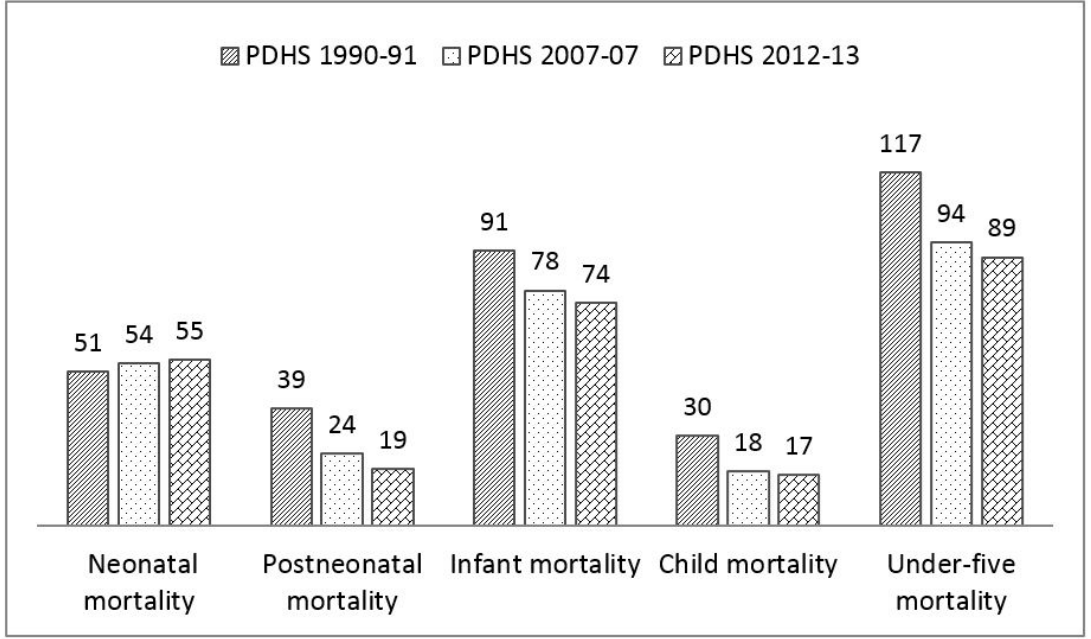
Figure 1. Child mortality (per 1000 live births) from the Pakistan Demographic and Health Surveys (PDHS) of 1990–1991, 2006–2007, and 2012–2013.